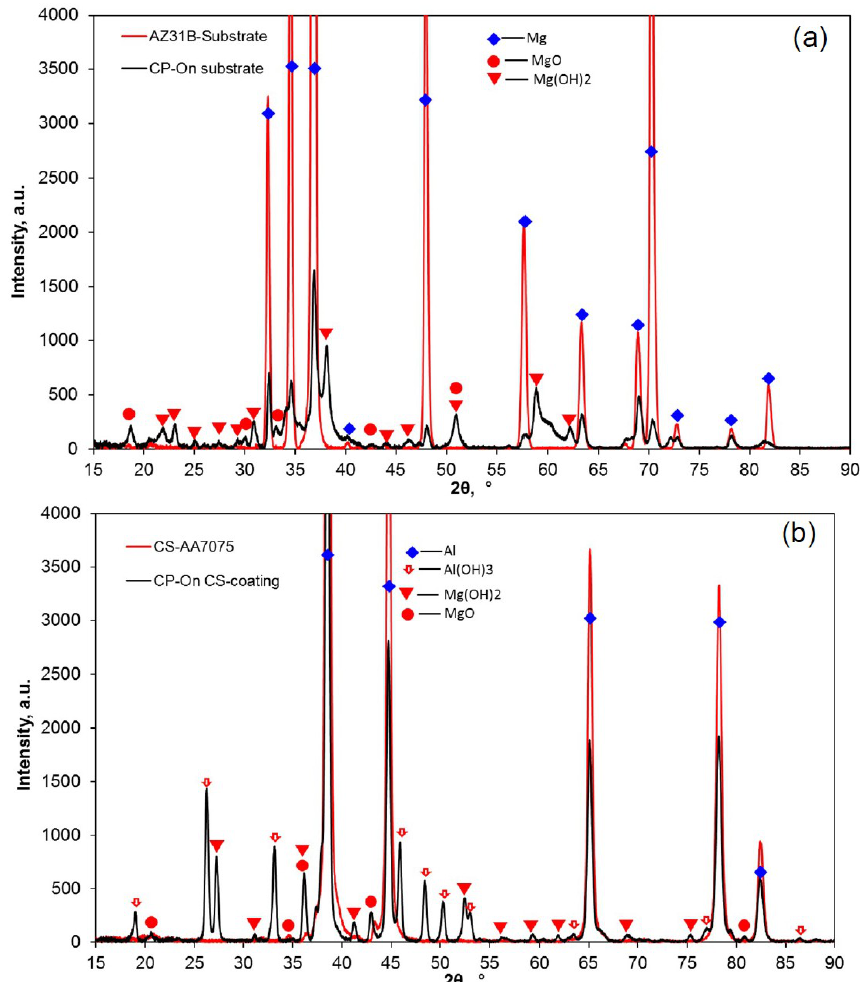
Figure 9. The X-ray diffraction (XRD) analysis of the corrosion product (CP) formed during fatigue test of AZ31B Mg alloy coated with AA7075 alloy; ( a ) CP on the substrate and ( b ) CP on the coat.